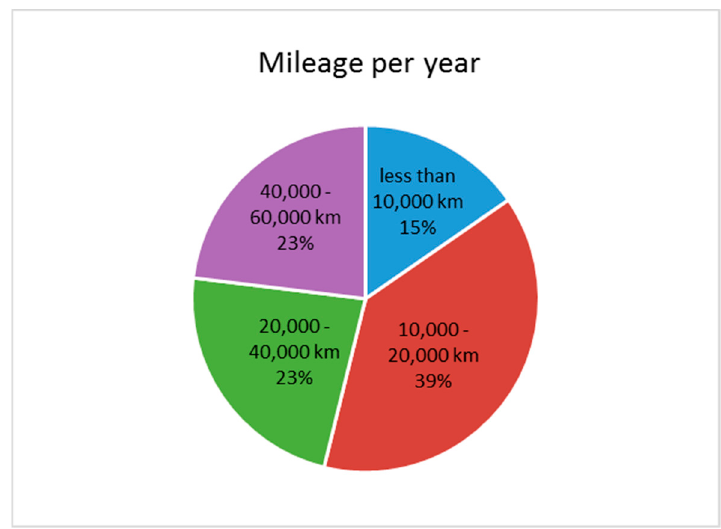
Figure 4. Representation of drivers in terms of mileage per year.